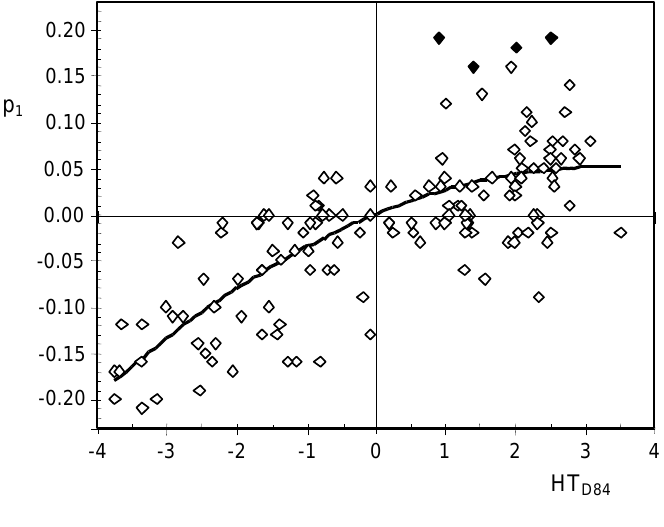
Figure 1. Plot of fitted regression analysis of p principal component of Dravnieks’ Atlas) versus HT The fitted curve corresponds to Equation (4). The four highest residuals (filled points) are moderate